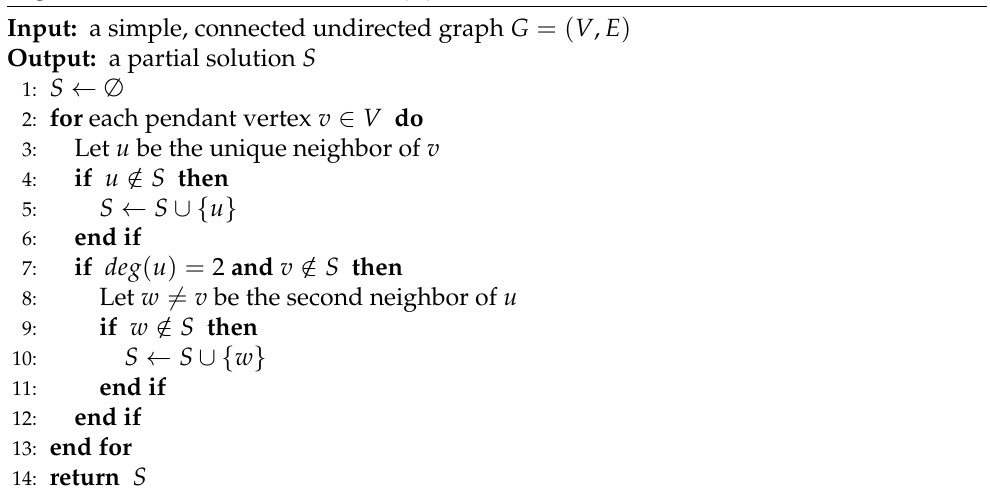
Algorithm 4 Function GraphPruning ( G